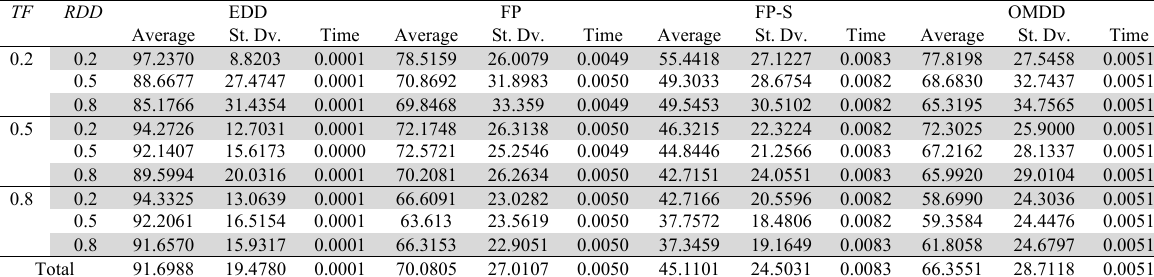
we can also observe that the MILP model obtained the largest percentual of optimality. Small-sized test instances: RDI values for TF and RDD (part